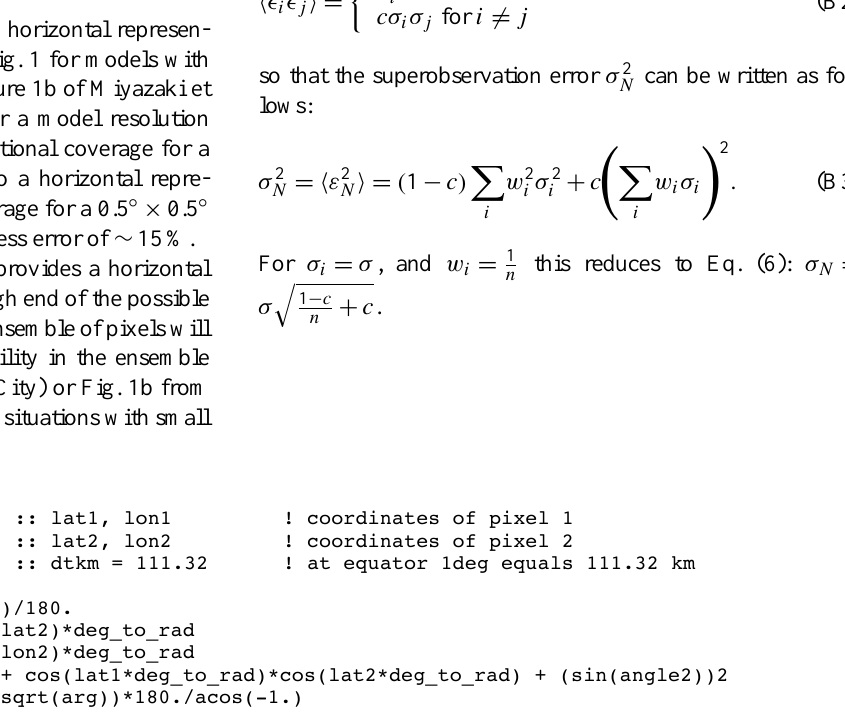
Figure A1. A simple distance calculation between two latitude, longitude pairs (lat1, lon1) and (lat2, lon2) is provided by the above Fortran90